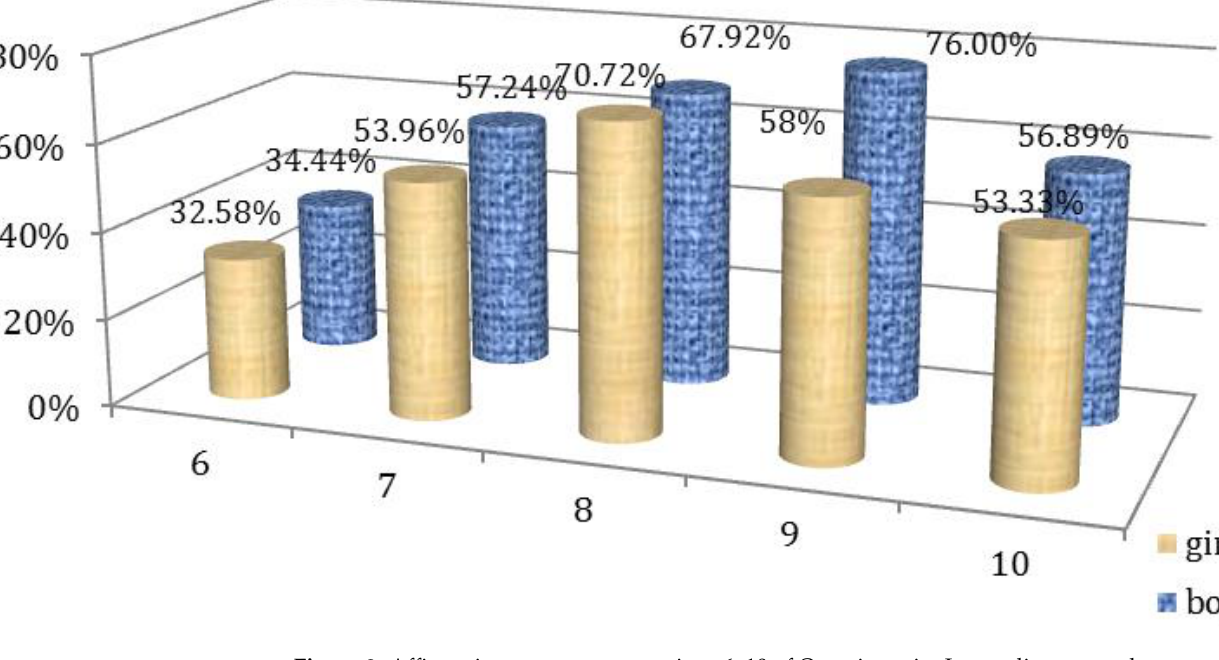
Figure 2. Affirmative answers to questions 6 – 10 of Questionnaire I according to gender.